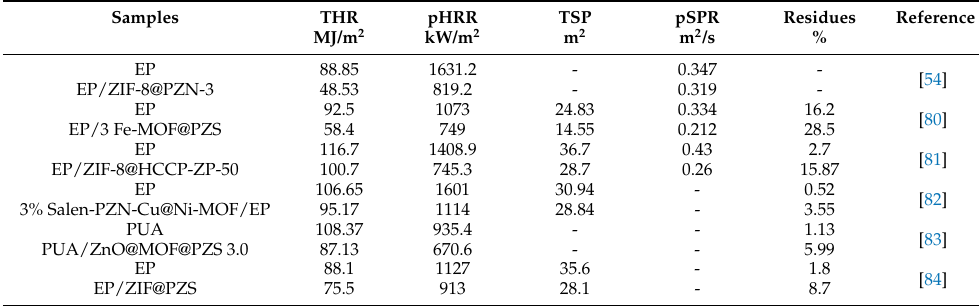
Table 2. Data on MOFs and phosphonitrile hybrids as flame retardants.